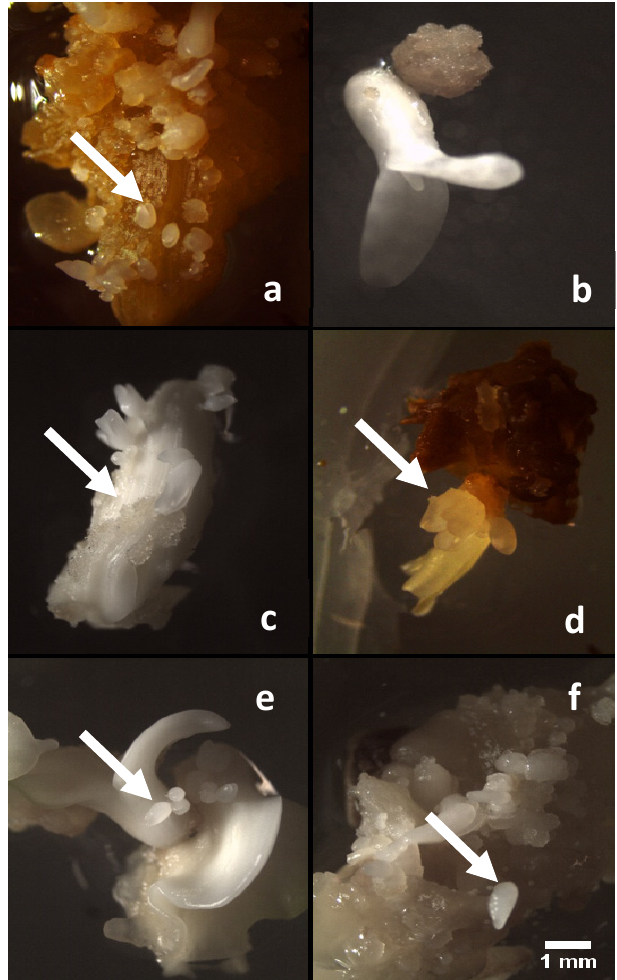
Figure 3. Effect of the ethylene inhibitors on somatic embryogenesis from callus derived from zygotic embryos at different concentrations of AgNO 3 20 µM ( a ), salicylic acid 20 µM ( b ), CoCl 2 20 µM ( c ), AgNO 3 40 µM ( d ), salicylic acid 40 µM ( e ), and CoCl2 40 µM ( f ), after four weeks in culture. (Scale bar = 1mm). * White arrows show the well-formed embryos. Table 3. The effect of ethylene inhibitors on the percentage of embryogenic callus formation and the number of somatic embryos recovered. The data are reported as the mean ± standard deviation. The mean denoted by different letters are significantly different (Duncan’s test, p < 0.05).